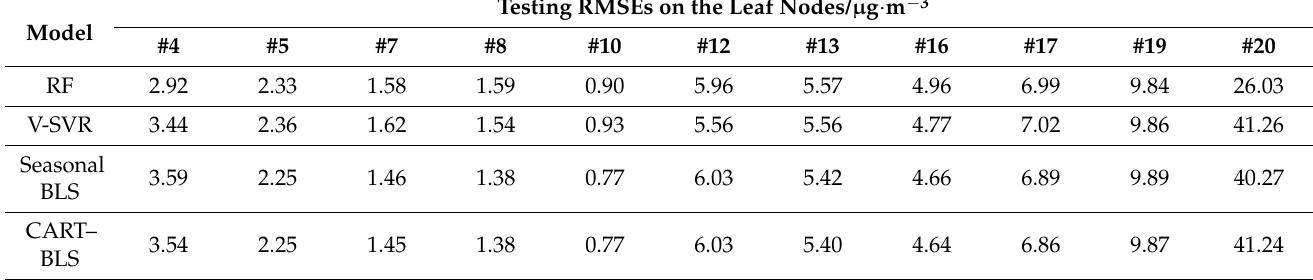
Table 3. RMSE comparison of different models. The # has no special meaning, and #4 represents node 4.